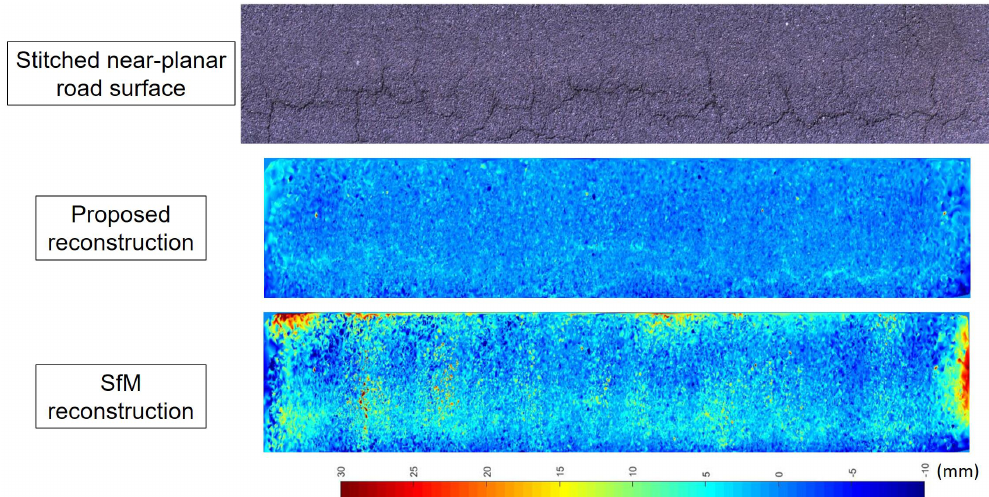
Figure 18. The comparison between the proposed and the traditional SfM technique for reconstructing a section of road surface. Top: a road surface image stitched by 20 consecutive images captured. Middle: A colormap image for the depth ( { G } Z direction) values of reconstructed X r techinque. Bottom: A colormap image for the depth ( { G } Z direction) values of reconstructed X r using traditional SfM.